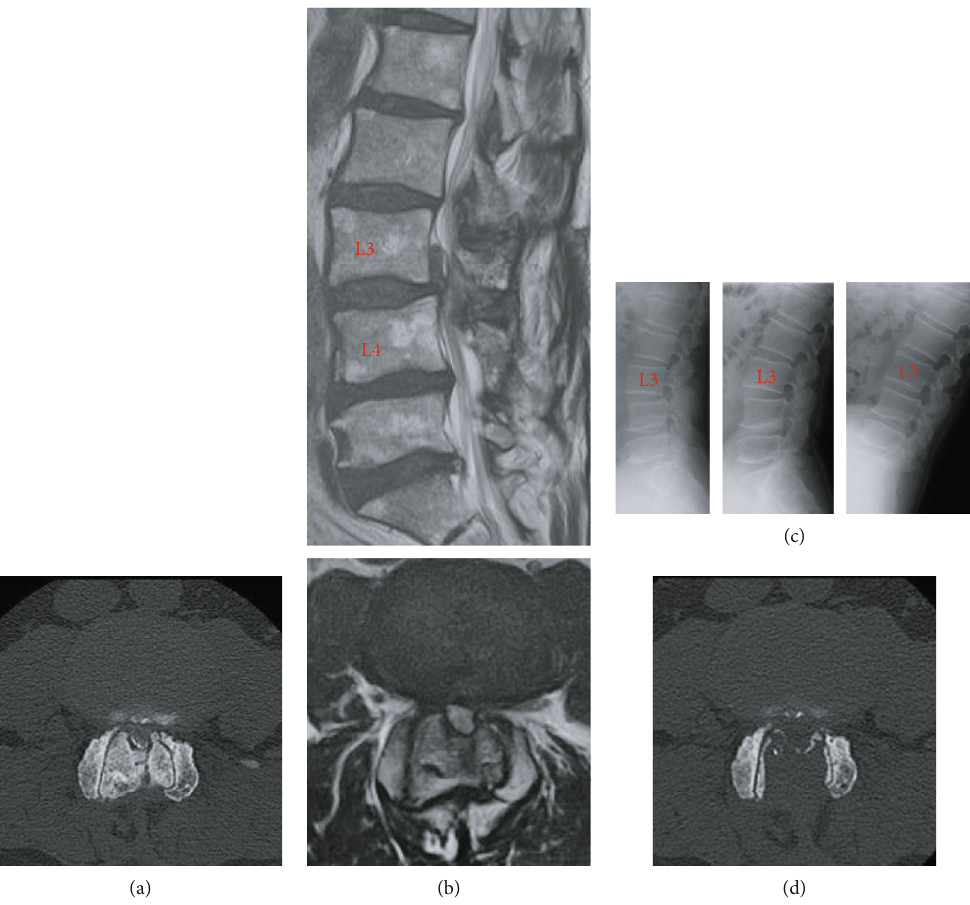
Figure 4: Radiographic images before and after the third surgery. (a) Computed tomography (CT) myelogram before the third surgery showing re-restenosis due to marked bone overgrowth of the lamina and facet joints. (b) Magnetic resonance (MR) image before the third surgery showing central canal restenosis due to marked bone overgrowth and disc herniation of L3/L4. (c) Dynamic X-ray images (neutral, extension, and fl exion position) before the third surgery showing no signi fi cant changes in lumbar alignment or spinal stability. (d) CT image 1 day after the third surgery showing the results of the bilateral laminectomy at